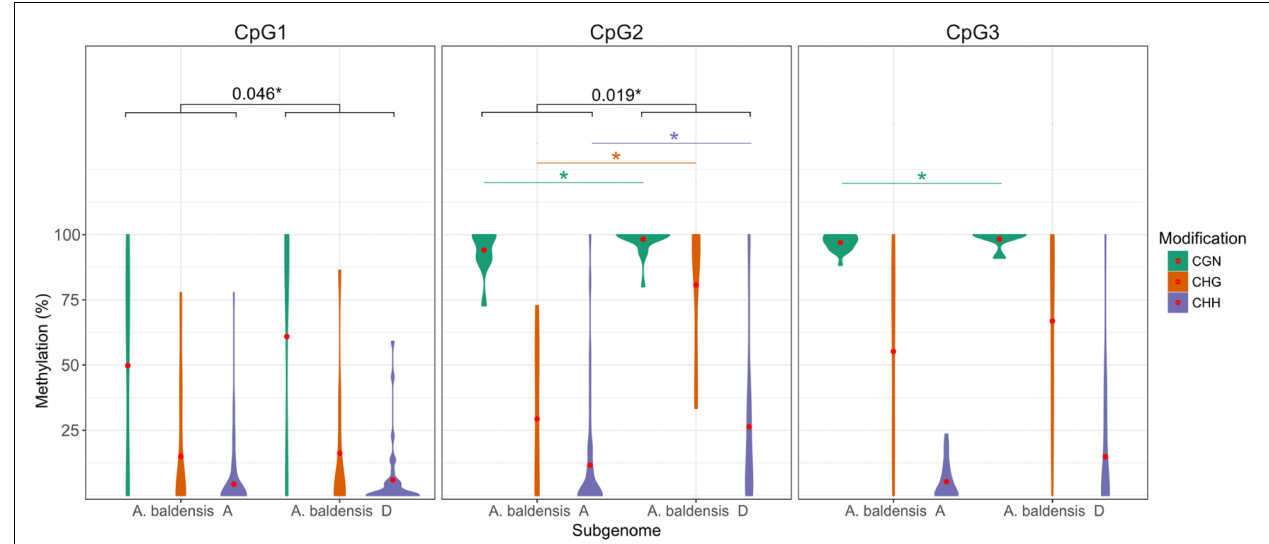
FIGURE 6 | Comparative 35S rDNA methylation analysis between the subgenomes A and D of A. baldensis . Different colors represent different modifications. Red dots represent mean methylation level. Statistical significance for different modifications is represented as: * for α ≤ 0.05.